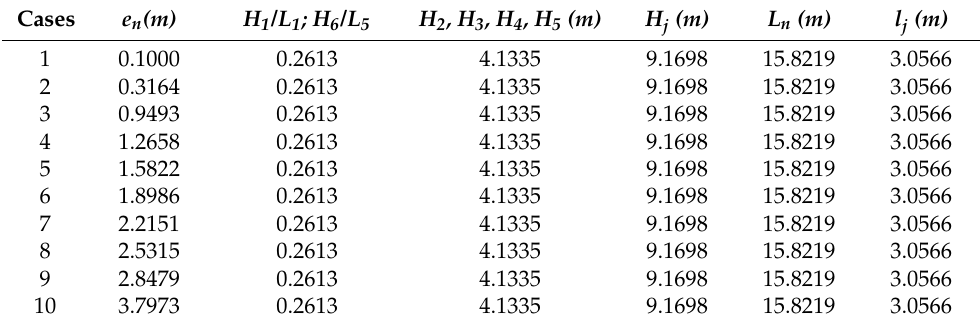
Table A3. Thickness of the columns that divide the devices, with five coupled